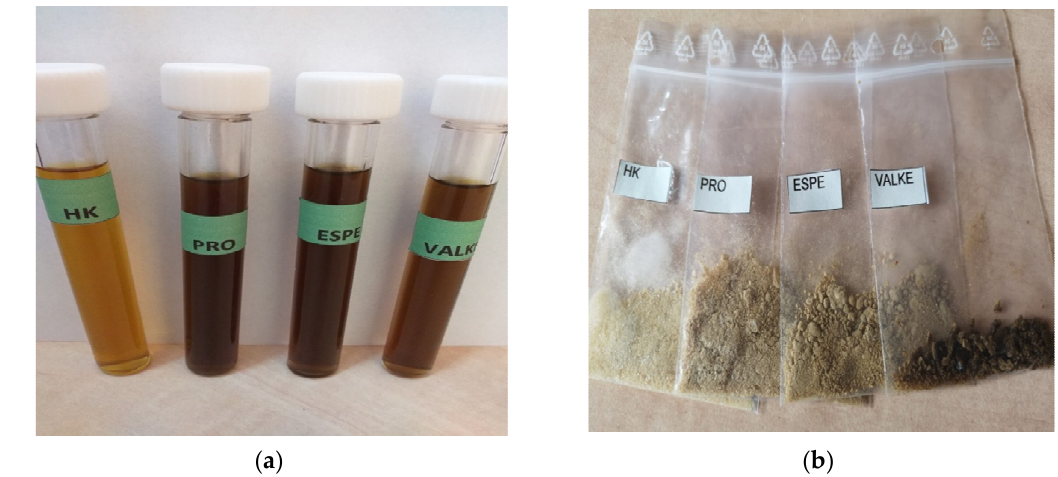
Figure 1. ( a ) Alkaline (HK) and enzymatic keratin hydrolysates (PRO, ESPE, VALKE); ( b ) lyophilised keratin hydrolysates (HK, PRO, ESPE, VALKE).